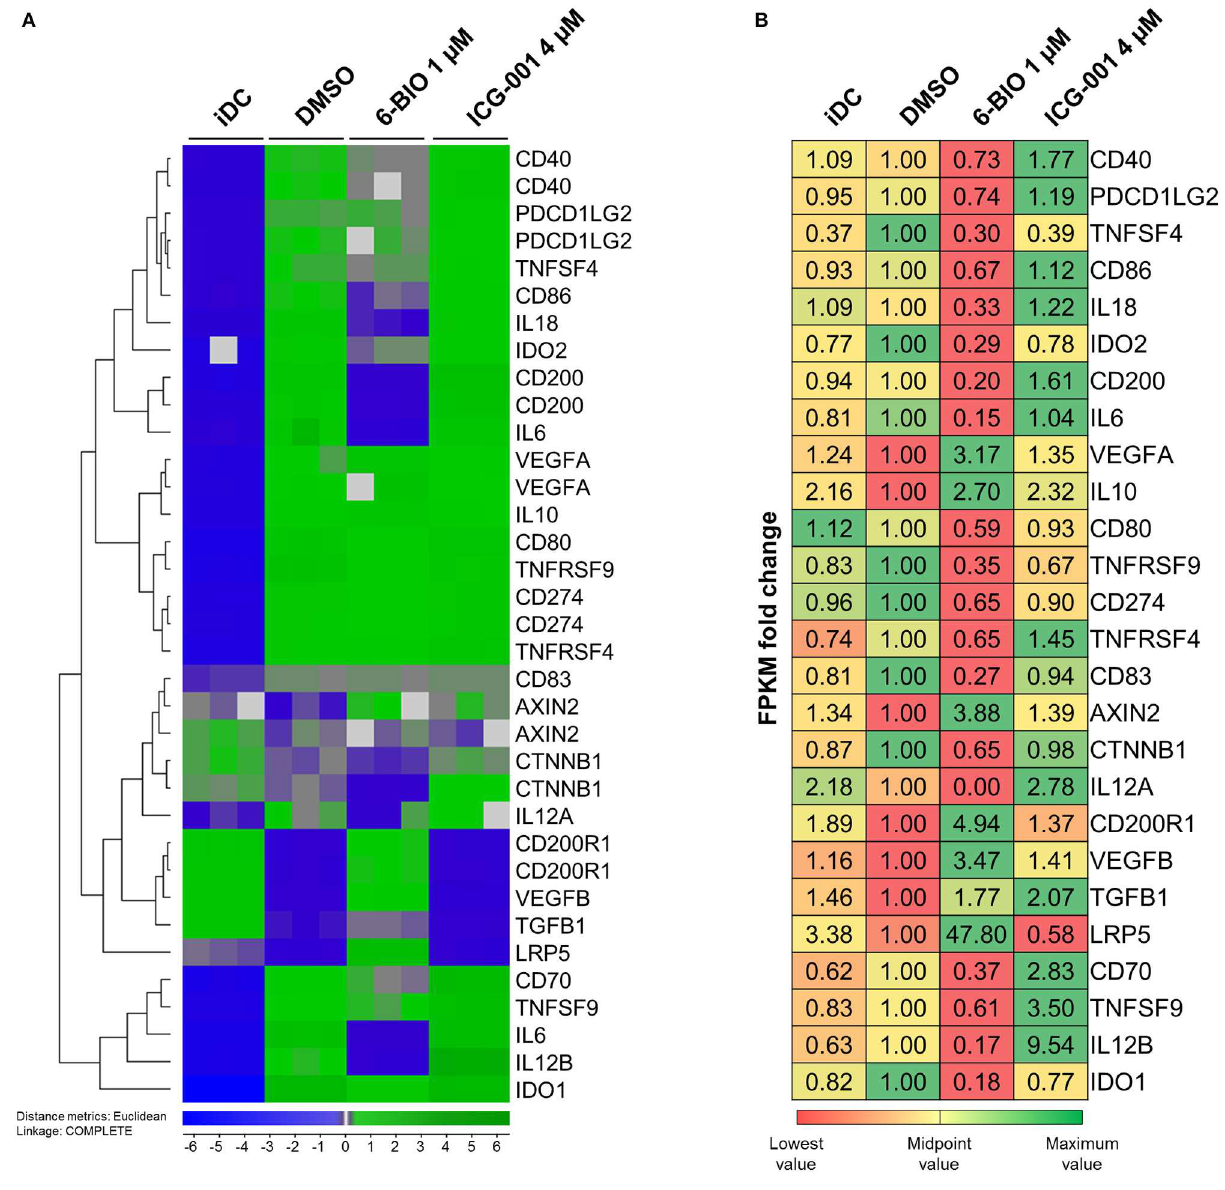
FIGURE 5 | moDCs obtained from healthy donor and treated with DMSO, 1 µ M 6-BIO or 8 µ M ICG-001 for 24h with 30ng/ml of LPS for the last 23h, or left untreated as iDC. (A) Total RNA was subjected to whole-genome microarray analysis. Heat map of selected gene expression data based on the supervised hierarchical cluster analysis (J-Express TM software) of different treatments. (B) Total RNA (500 ng) was used to generate RNA-seq libraries. Values of the expression of selected genes were based on fold change of normalized fragments per kilobase of transcript per million mapped fragments (FPKM) for each gene of each sample. Fold change was compared to untreated DMSO (vehicle)